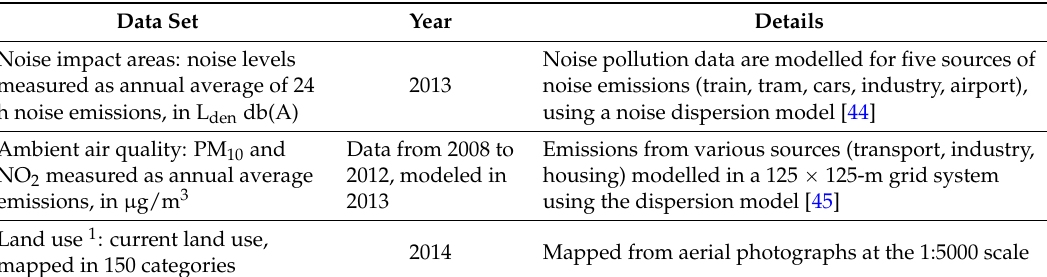
Table 1. GIS datasets.